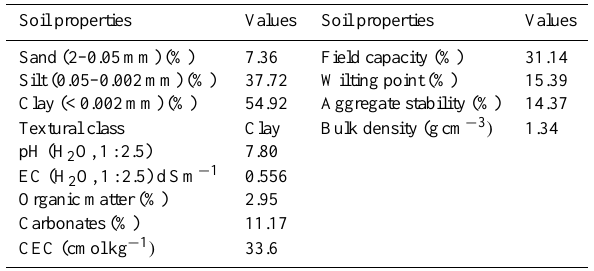
Table 1. Properties of the soil used in the experiment Soil properties Values Soil properties Values Sand (2–0.05mm) (%) 7.36 Field capacity (%) Aggregate stability (%) 14.37 Textural class